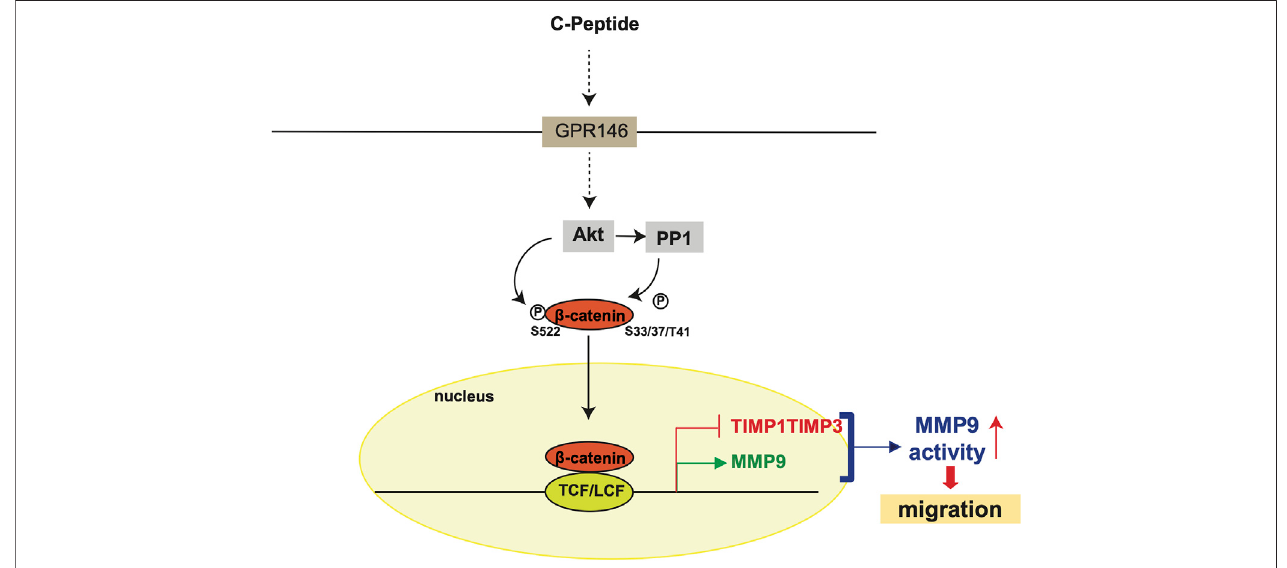
FIGURE 6 | Hypothetical model of C-peptide-enhanced migration in undecidualized human endometrial stromal cells. C-peptide activates Akt, which may occur throughGPR146,inundecidualizedhumanendometrialstromalcells(UnD-ESCs).ActivatedAktphosphorylates β -cateninatSer522anddephosphorylates β -cateninat Ser33/37/Thr41 by activating PP1. β -catenin is then translocated to the nucleus where β -catenin/TCF-1/LEF binds to the proximal promoter regions of MMP9, TIMP1, and TIMP3. The upregulation of MMP9 expression and downregulation of TIMP1 and TIMP3 expression enhanced MMP9 activity, resulting in enhanced cell migration in